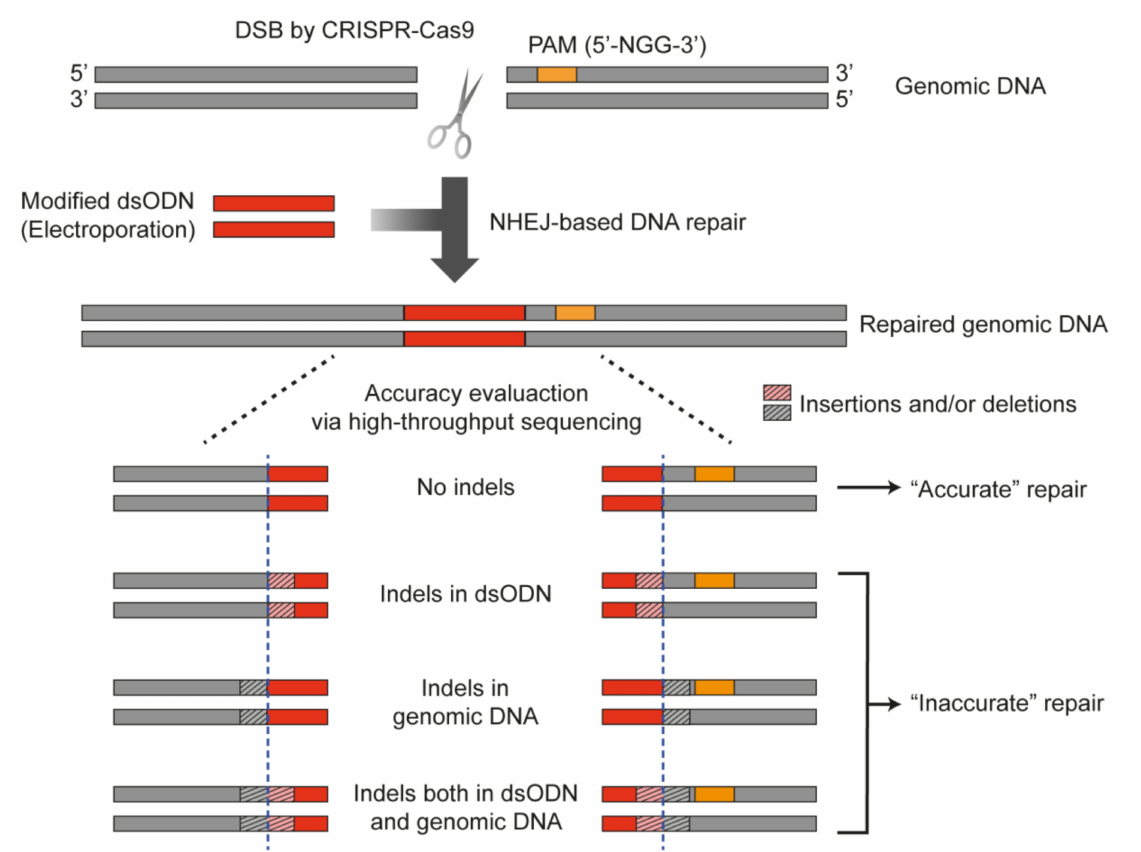
Figure 1. Schematic illustration of measuring the repair accuracy by the NHEJ pathway. A 34-mer oligonucleotide was used for limiting the DSB generation to one time. The accurate repair was determined only when there were no indel mutations at both the DSB and in the